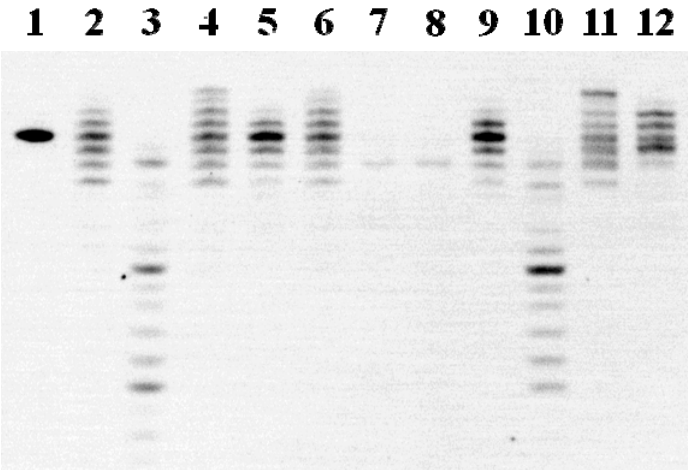
Figure 2. Successive incorporation of 2 ′ ,4 ′ -bridged nucleotides using analogue 3 with various DNA polymerases; KOD Dash (lane 2), wild type KOD (lane 3), KOD 1 (lane 4), KOD 2 (lane 5), KOD 3 (lane 6), KOD 4 (lane 7), KOD 5 (lane 8), KOD 6 (lane 9), KOD 7 (lane 10), KOD 8 (lane 11), and Vent(exo-) (lane 12). Primer extension reactions were performed for 1 h at 74°C under enzyme concentration of 0.4 U/ μ L. Primer P2 only migrated in lane